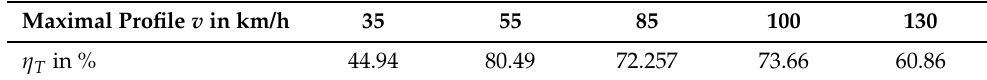
Table 6. Total efficiency for each velocity profile.